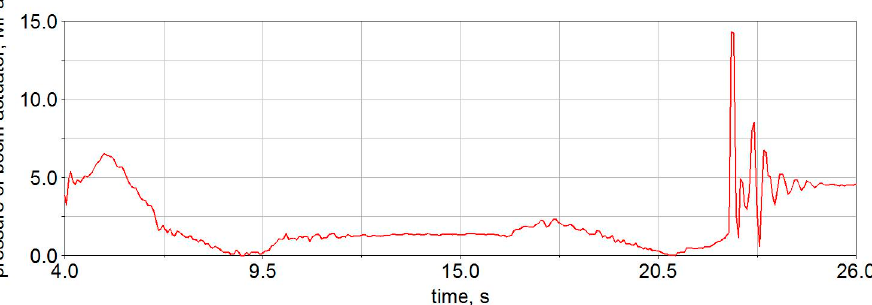
Figure 14. Plot of boom cylinder pressure for manipulator without counterbalance valves and effector velocity 300 mm/s.